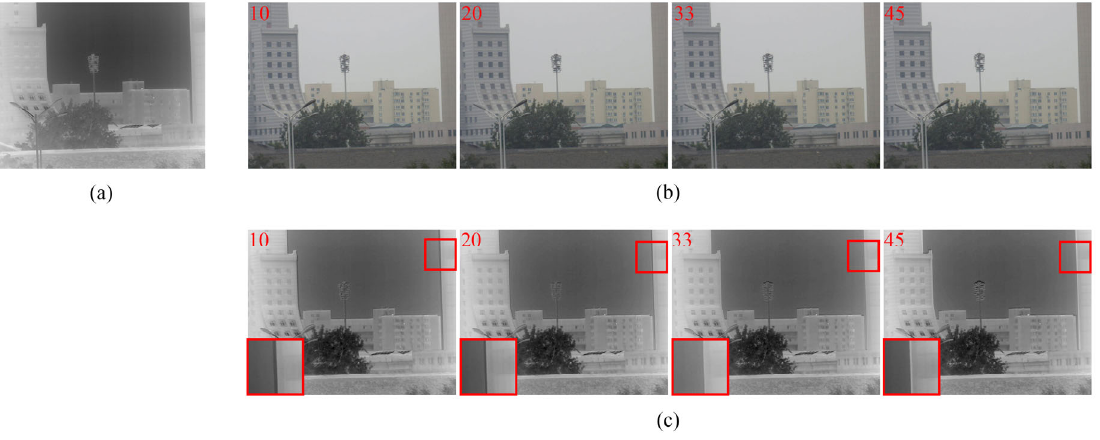
Figure 5. Sequence of pairs of input and fusion images in the zoom process: ( a ) infrared image; ( b ) sequence of visible images; and ( c ) sequence of gray fusion images (the details in red boxes are enlarged to display).